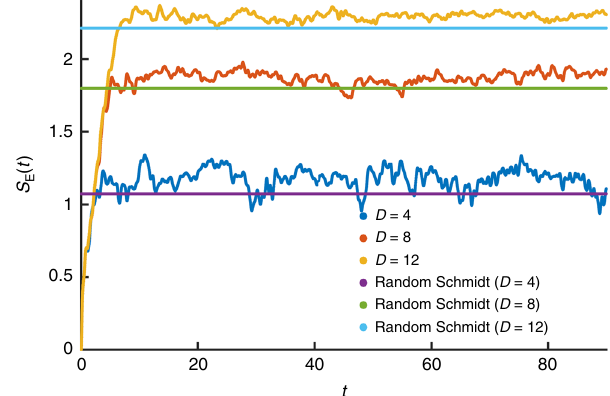
Fig. 4 Entanglement entropy across a bond compared to randomly distributed Schmidt coef fi cients. At a given bond dimension, the entanglement entropy will saturate after a short time. The saturation value for the entanglement entropy is in strong agreement with a random uniform distribution of Schmidt coef fi